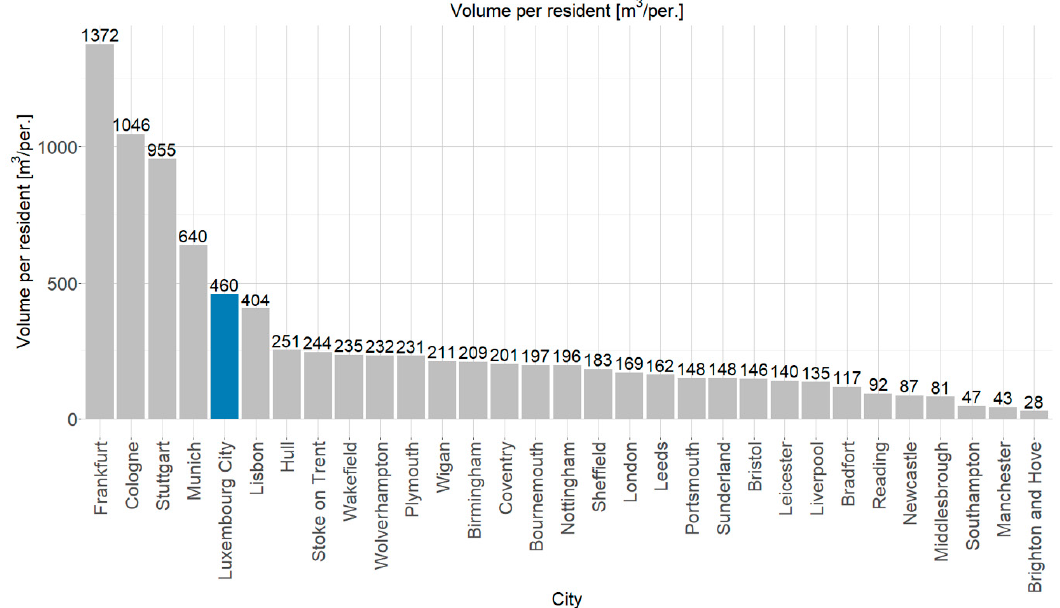
Figure 17. Buildings 3D Density Index in European cities (Source: based on data in publication [44,45,54]).